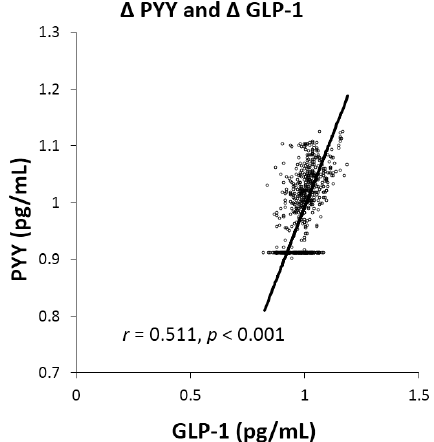
Figure 3. Correlation of postprandial concentrations of ∆ GLP-1 and ∆ PYY after both meals in all men. Spearman’s correlation was calculated for the relationship between changes in concentrations of investigated parameters. r = 0.511, p < 0.001. Table 1. Characteristics of the study population. Data are means ± standard deviation (SD).